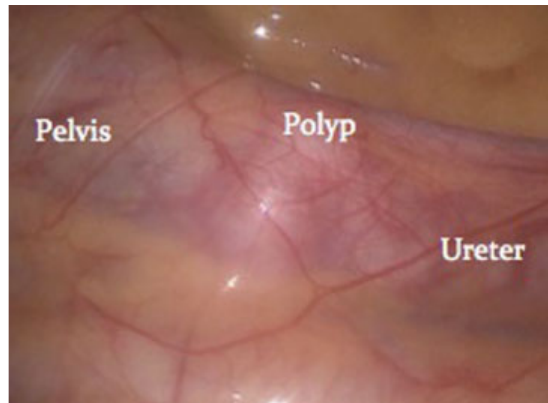
Fig. 2 Transmesocolic view of ureteral polyp during laparoscopy through retroperitoneum.